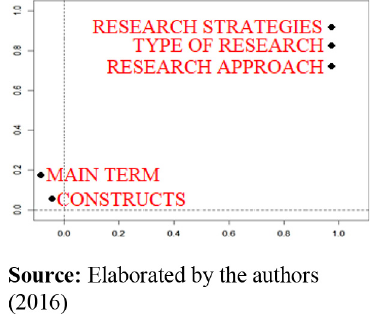
Figure 2. Correlation between the characteristics of the